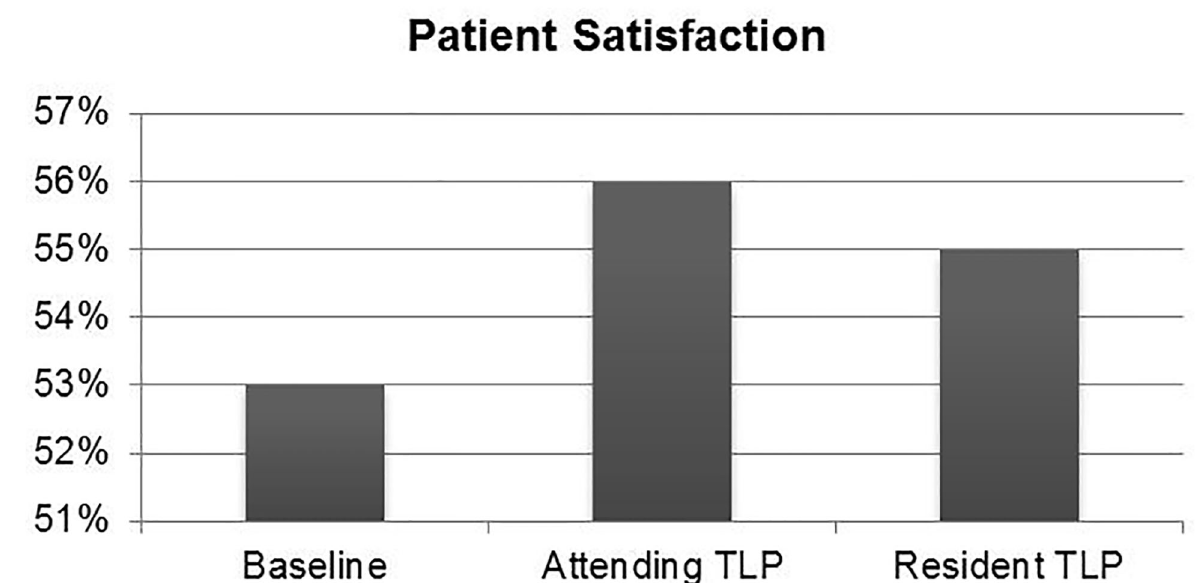
Figure 6. Difference in proportion of “very good” patient satisfaction scores between attending triage liaison provider (TLP), resident TLP, and historical